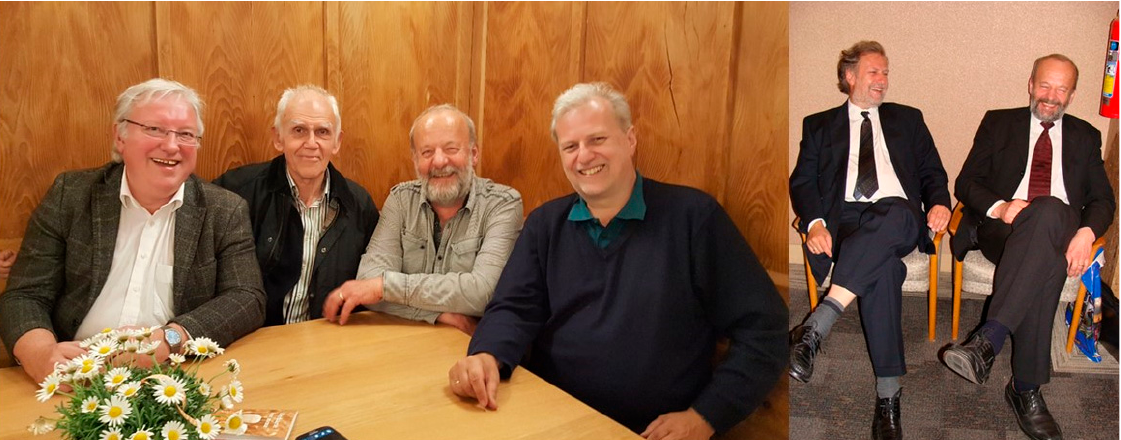
Figure 2. Nikolaus Bresgen and Werner Siems, Mai 2022. Left. Werner Siems, Rudolf Jörg Schaur (a close collaborator of Hermann Esterbauer), Peter Eckl and Nikolaus Bresgen (from left) debriefing their joint lecture series on “Oxidative stress and lipid peroxidation” at the University of Salzburg. Right. Peter Eckl and Nikolaus Bresgen—close collaborators for more than 25 years-in a typical conversation at the 4th international meeting of the HNE-Club 2008 in Karuizawa,